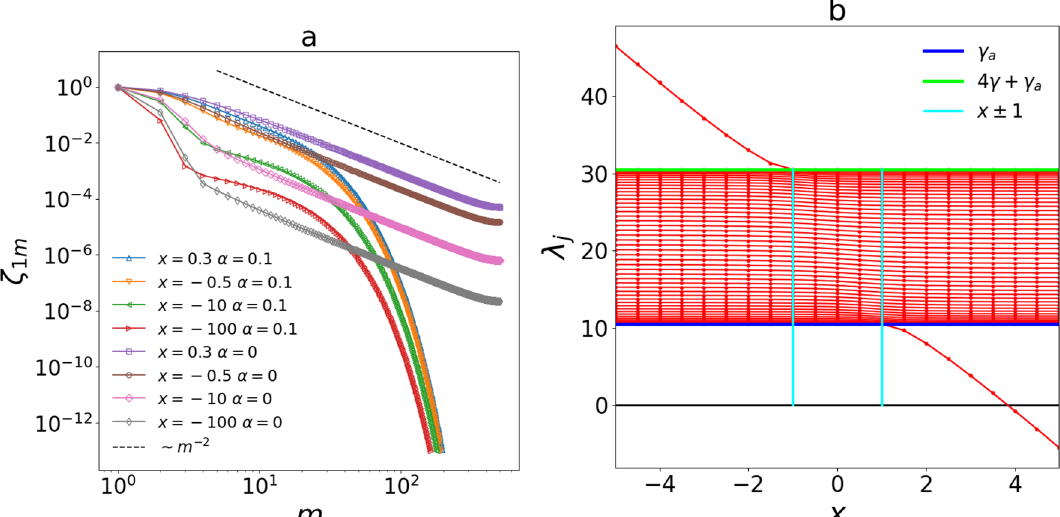
Figure 4. ( a ) Spatial correlation function for different quasi-Toeplitz cases in both HHP and NHHP. We can see that the two phases are stable also for large values of negative x . The entries of 1 and diagonalising s for t = ≫ accumulate at the boundary of the band We also note that in the range of interest for the NHHP ( x the stability of the system. In both panel, we used L